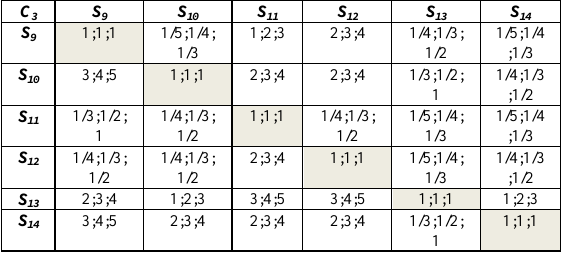
Table 4. Matrix of pairwise comparisons of the sub-criteria in relation to the criterion C 3